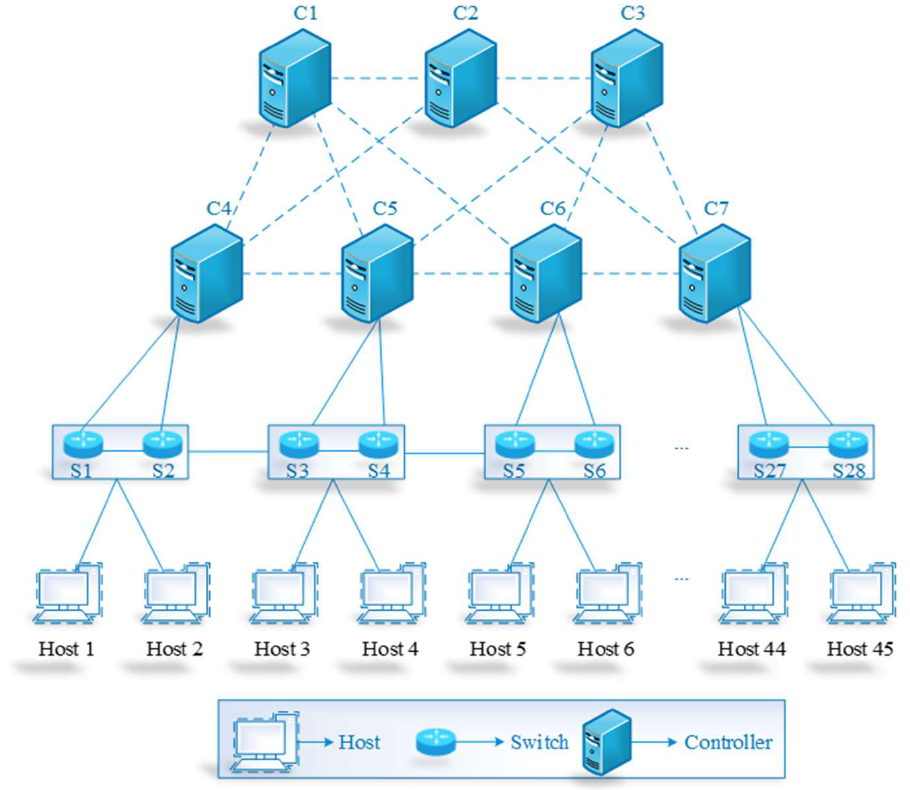
Figure 2. Multi-controller SDN simulation environment.